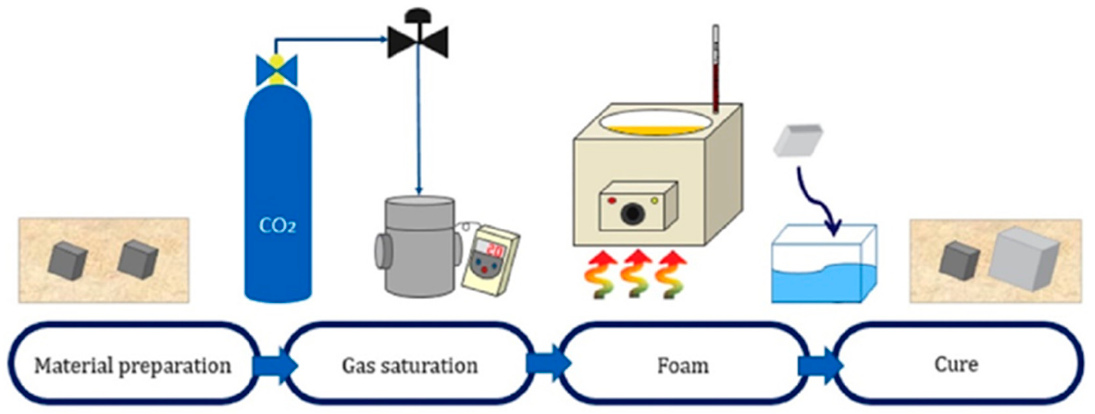
Figure 1. Procedure of the batch process.